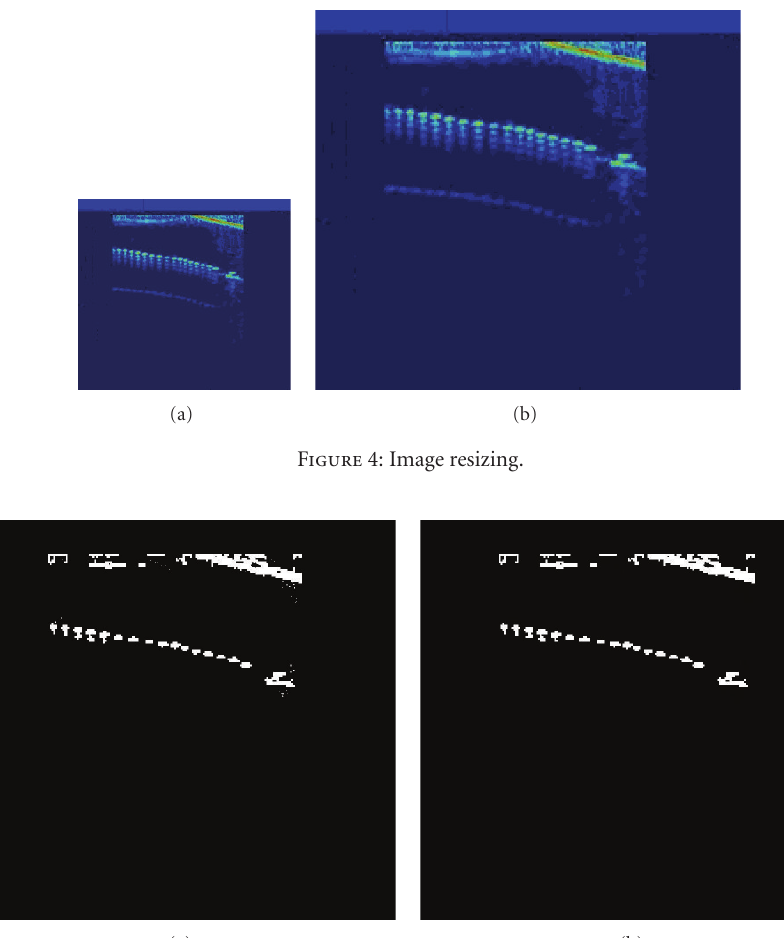
Figure 5: Noise reduction for kind of sample image. (a) before (b) after.